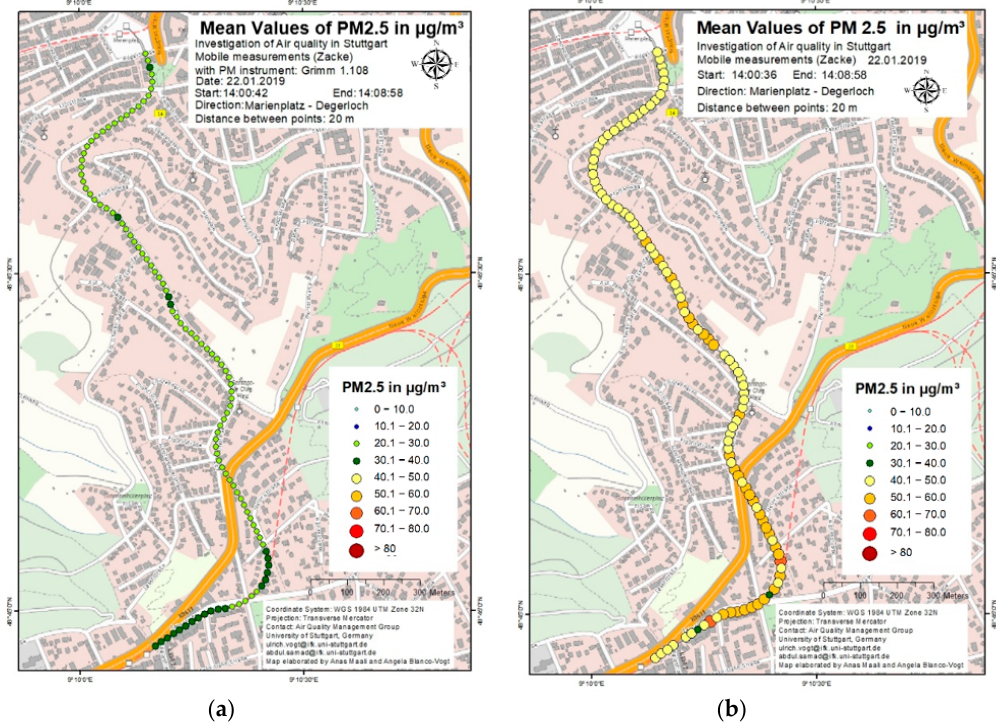
Figure 13. PM2.5 concentration using ( a ) mobile aerosol spectrometer ( b ) sensor-monitoring box.